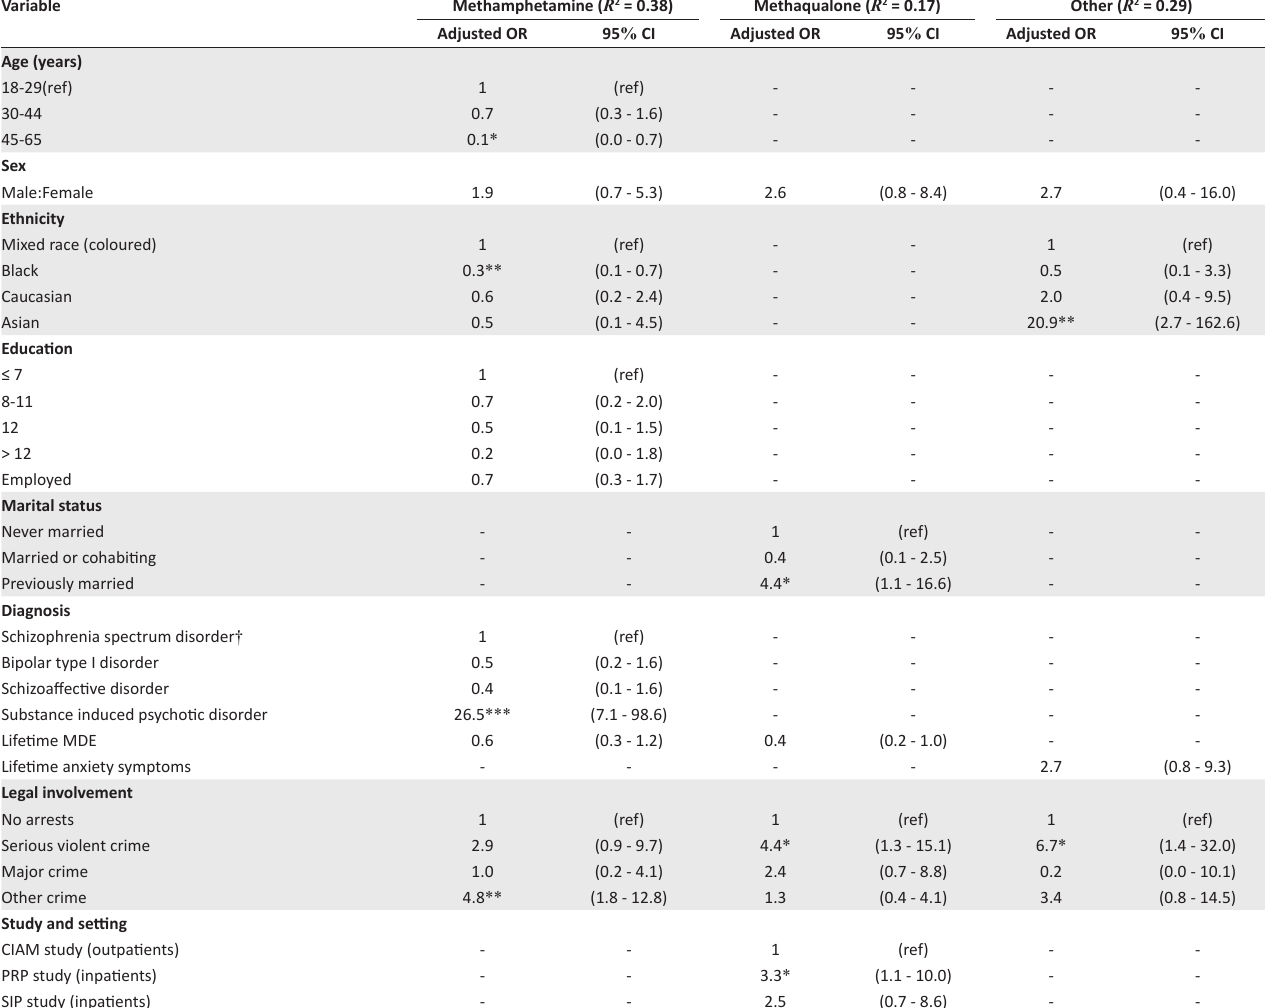
TABLE 5: Adjusted demographic and clinical association with methamphetamine, metaqualone and other substance use disorders. ( N = 248).